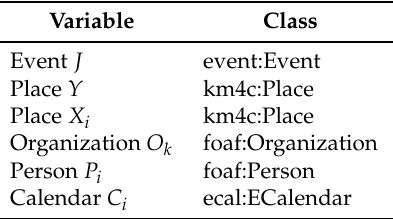
Table 1. Mapping between variables and ontology classes performed in process Θ .3.